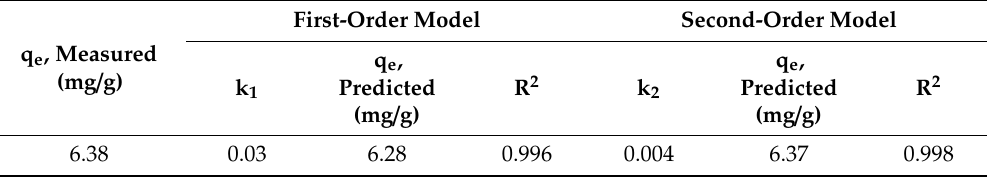
Table 2. Model-predicted kinetic parameters for P adsorption by waterworks sludge ceramsite (WSC). First-Order Model Second-Order Model q e , Measured q e , (mg / g) k 1 Predicted R 2 Predicted (mg / g)